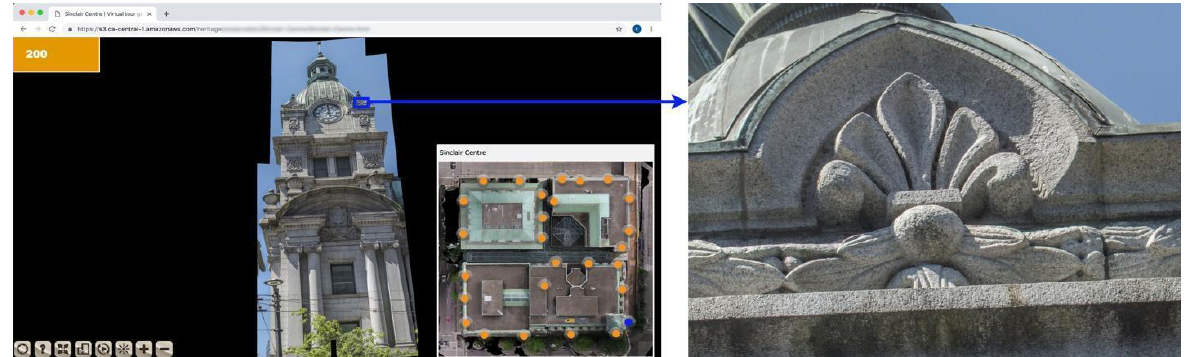
Figure 3: Key plan with clickable hotspots, 2 Gigapixel mosaic elevation, and zoomed in portion of image.